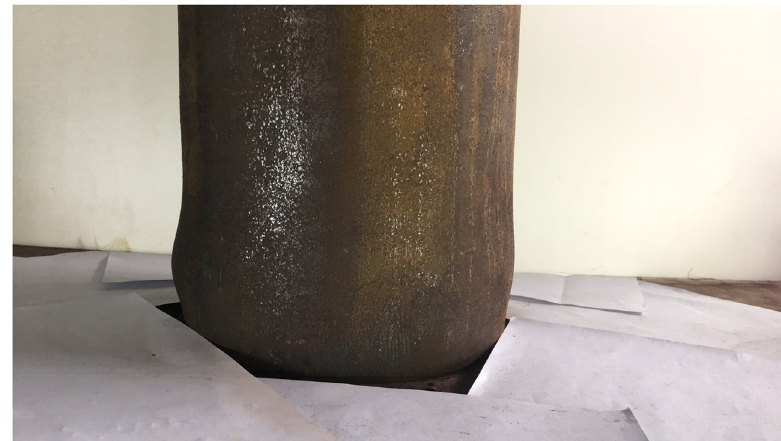
Figure 6: Typical failure mode of test piece.